Question: Which visualization type does this figure use?
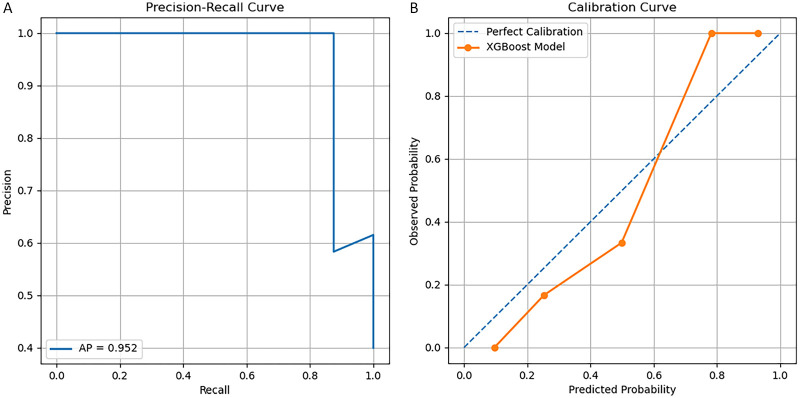
Answer: line